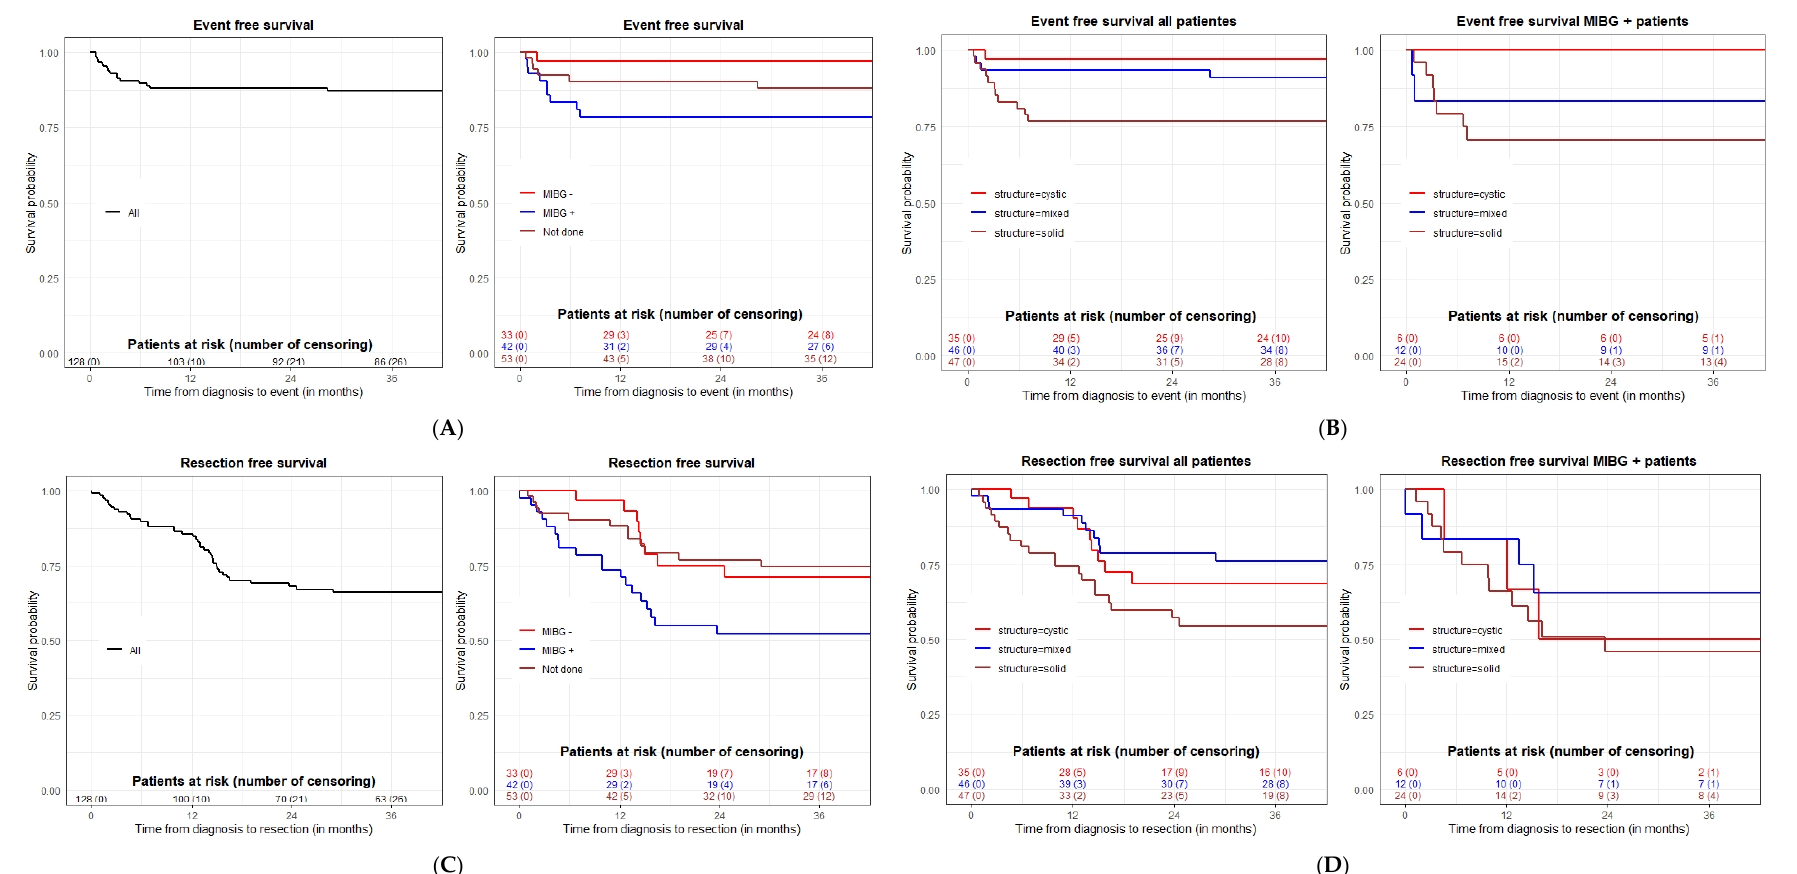
Figure 2. ( A ) Left: Event-free survival for the whole cohort ( n = 128) patients enrolled in the study. Right: EFS for three cohorts of patients based on MIBG procedure: positive (Group 1, n= 42), negative (Group 2, n = 33) and patients with MIBG not done (Group 3, n = 53). ( B ) Left: Event-free survival by mass structure for the whole cohort ( n = 128) patients enrolled in the study. Right: EFS by mass structure for the cohort of patients with MIBG-positive masses (Group 1 n = 42). ( C ) Left: Resection-free survival for the whole cohort ( n = 128) patients enrolled in the study. Right: RFS for three cohorts of patients based on MIBG procedure: positive (Group 1, n = 42), negative (Group 2, n = 33) and patients with MIBG not done (Group 3, n = 53). ( D ) Left: Resection-free survival by mass structure for the whole cohort ( n = 128) patients enrolled in the study. Right: RFS by mass structure for the cohort of patients with MIBG-positive masses (Group 1, n = 42).